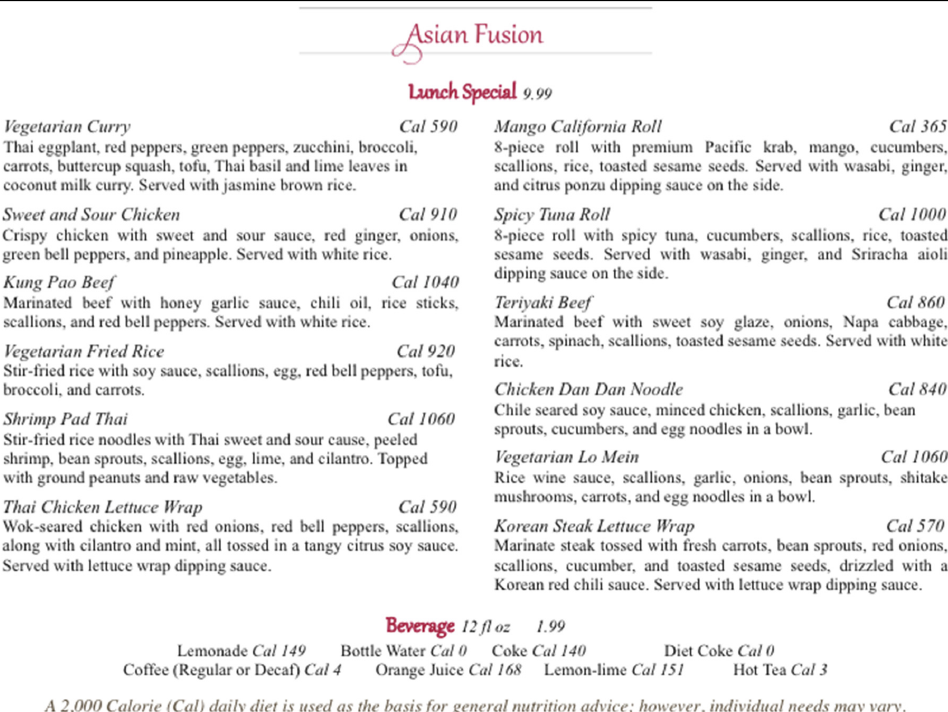
Figure A2. Asian Fusion First and Last Menu.